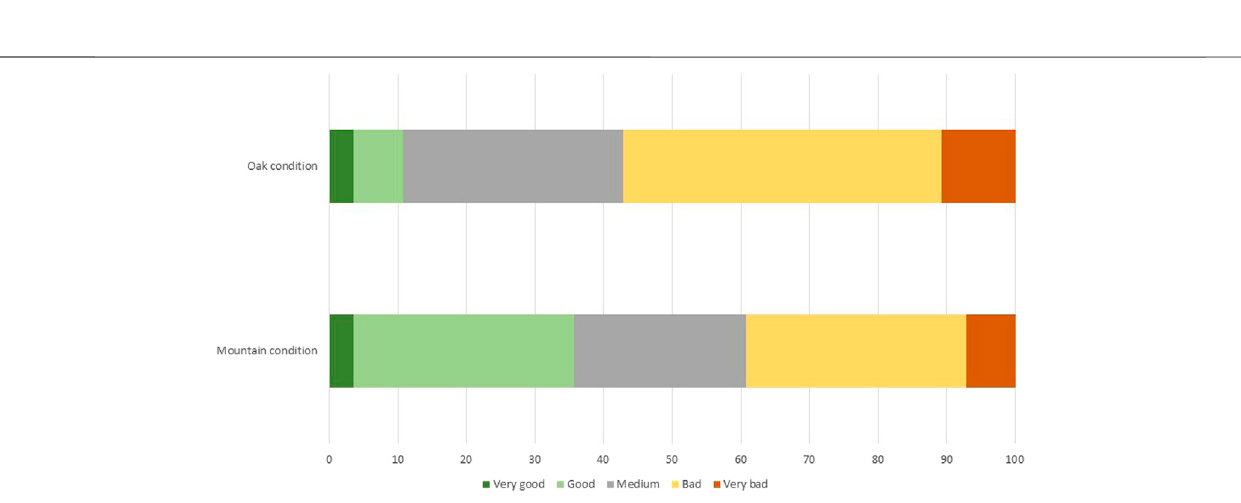
Frontiers in Environmental Science |